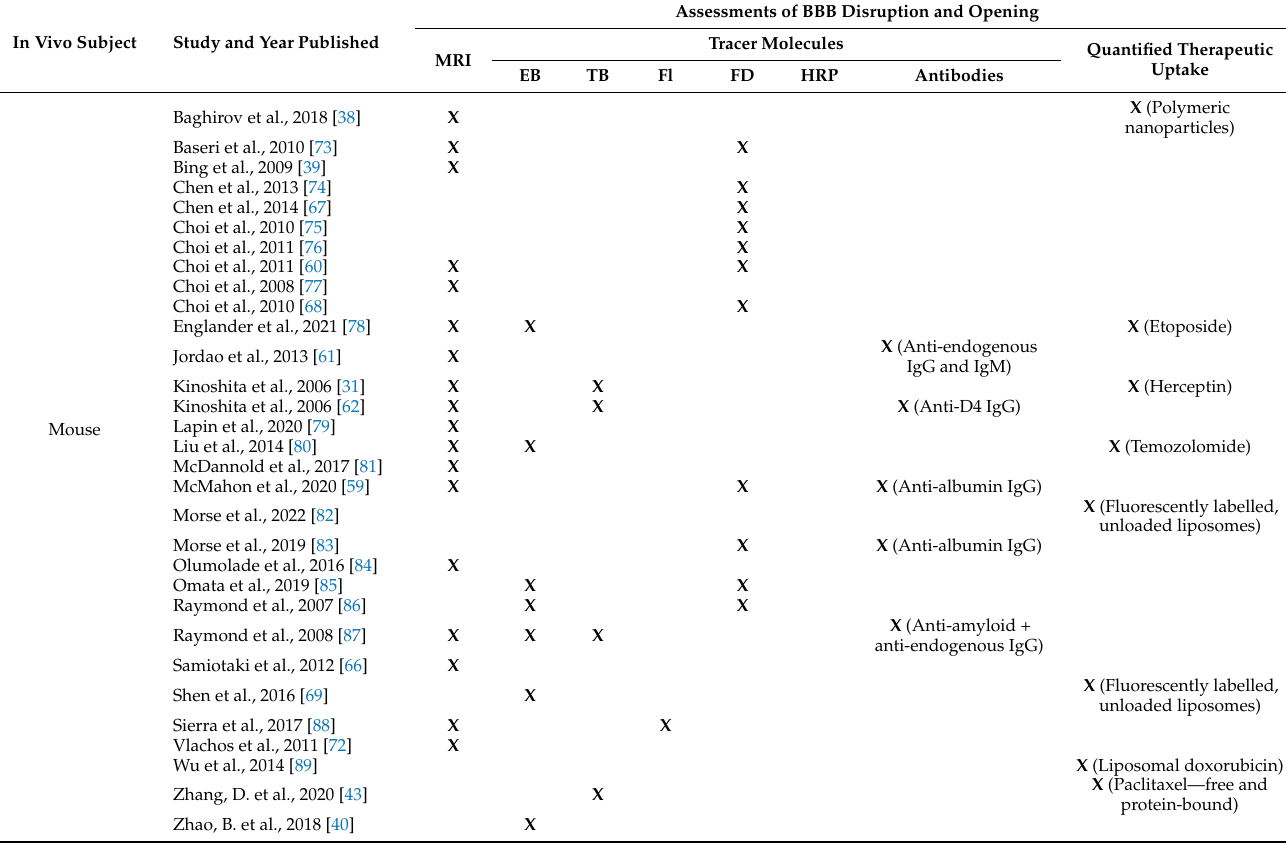
Table 1. Summary of the methods used by included protocols in assessing the extent of BBB